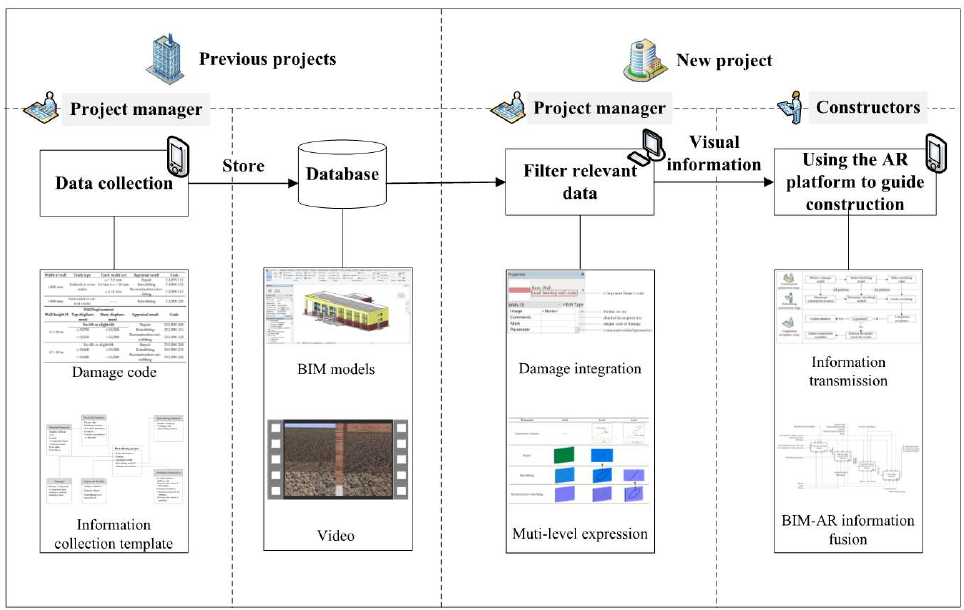
Figure 1. Building information modeling-augmented reality (BIM-AR)-based construction visualiza- tion method